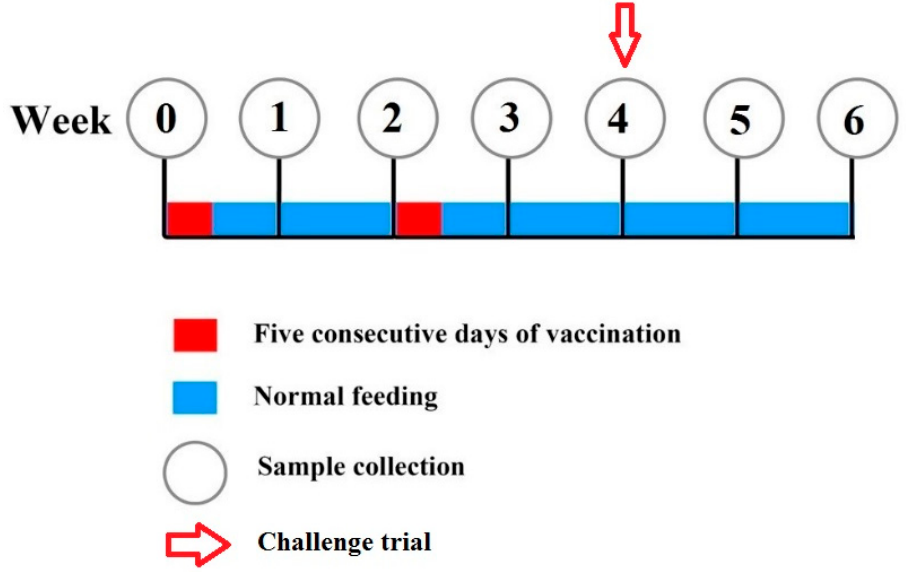
Figure 1. Feeding regime.